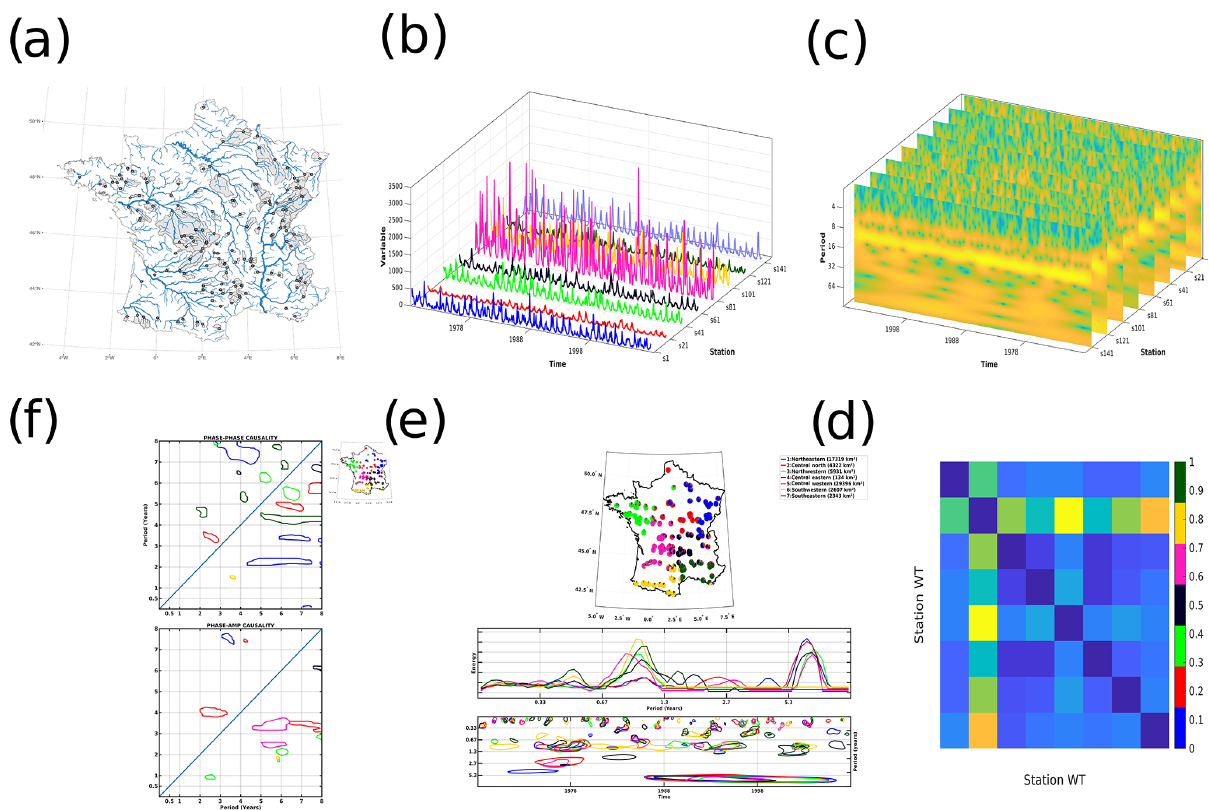
Figure 2. The workflow of this study is repeated for precipitation, temperature, and discharge data sets. (a) A total of 152 near-natural water- sheds are selected. (b) Each watershed is represented by a monthly time series from 1968 to 2008, discharge is measured at a gauging station, and precipitation and temperature are averaged over the watershed. (c) The continuous wavelet transform of each time series is computed, representing the timescale-dependent, nonstationary variability in each watershed. (d) The similarity between all 152 continuous wavelet transforms is computed and represented as a distance matrix. (e) Similar watersheds are grouped together into regions of homogeneous vari- ability using a fuzzy clustering algorithm (top). For each region, the relative importance of each timescale-dependent variability is represented with a global wavelet spectrum, and global wavelet spectra are superimposed for all regions (middle). The continuous wavelet spectra of the regions are superimposed (bottom). For clarity, only timescale and time locations with the most significant variability are shown (colored circles). (f) For each region, cross-timescale interactions are computed. The phase–phase interactions (top) identify any timescale’s phase that conditions another timescale’s phase. The phase–amplitude interactions (bottom) characterize any timescale’s phase that conditions the amplitude of another